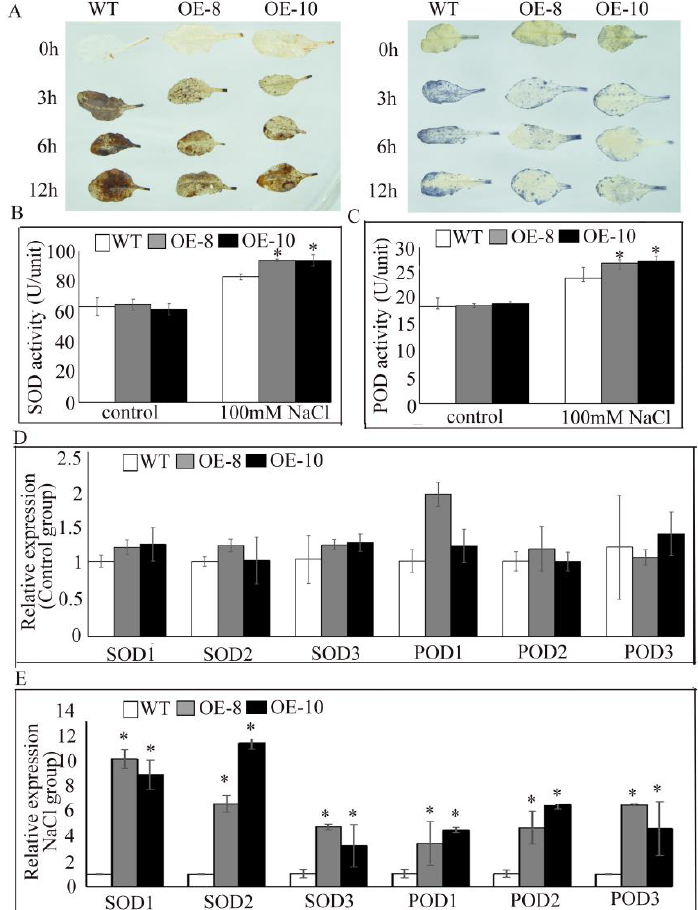
Figure 6. Analysis of ROS scavenging in PtrDHN-3- overexpressing Arabidopsis plants. ( A ) DAB and NBT staining were carried out in young leaves of WT and overexpressing plants treated with and without 100 mM NaCl for 0, 3, 6 and 12 h. WT and overexpressing plants were also evaluated for SOD ( B ) and POD ( C ) activity, and for SOD ( D ) and POD ( E ) gene expression. In the expression analysis, results were normalized to those of the Con plants (0 h), then data were log2 transformed. Genbank numbers of the SODs and PODs are shown in Supplementary Table S1. Three independent biological repeats were performed per treatment, and each experiment consisted of at least 9 transformed seedlings. * Indicates a significant difference according to Student’s t test at p < 0.05 compared with the WT plants.